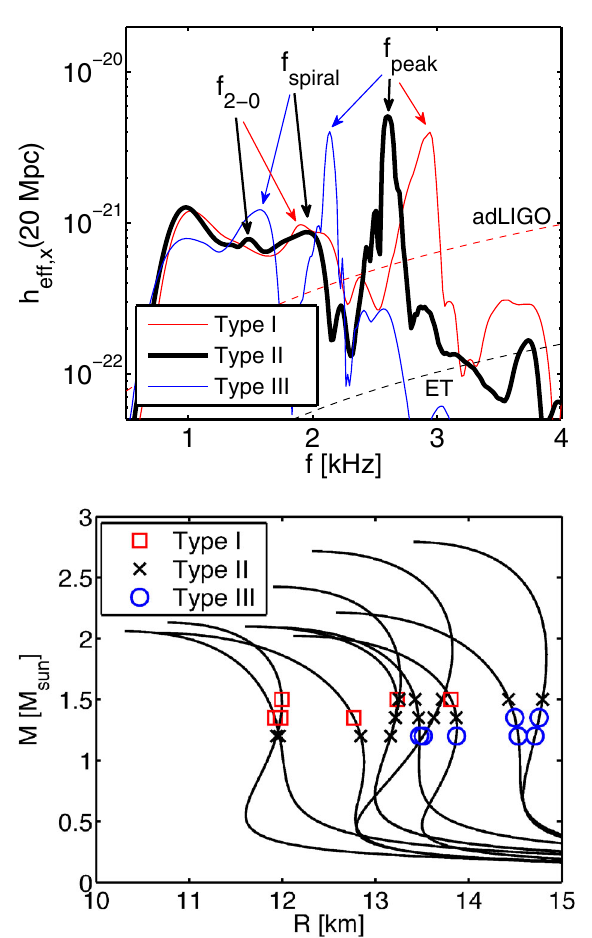
Fig. 34 Top panel : GW spectra of 1 . 35–1 . 35 M (cid:3) mergers with a soft (red), intermediate (black) and stiff EOS (blue), at a reference distance of 20 Mpc. Lower panel : Different types of merger dynamics are indicated for several EOSs and different masses (in each case, half of the sum of individual pre-merger masses is shown). (Image reproduced with permission from Bauswein and Stergioulas 2015, copyright by